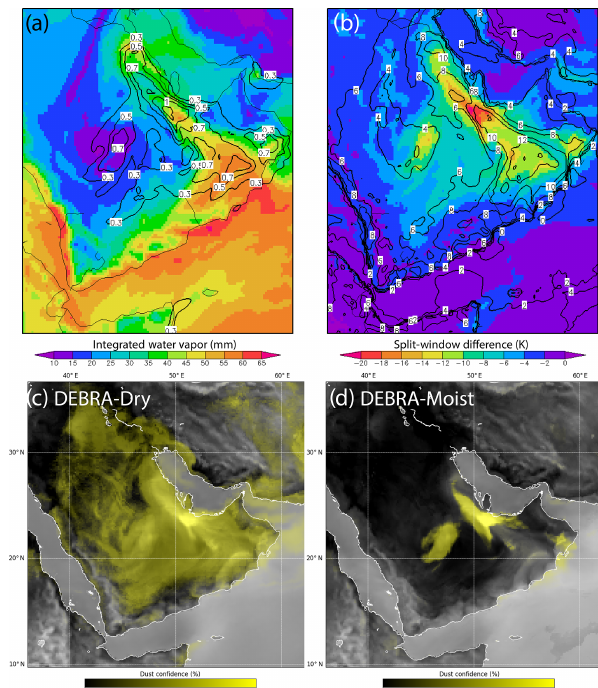
Figure 13. Model-based analysis of water vapor impacts on SWBTD-based dust detection, based on a WRF–Chem simulation valid at 12:00UTC on 4 August 2016. Panels show (a) shaded IWV overlaid by contours of aerosol optical depth at 10.35µm, (b) shaded SWBTD for a dry atmosphere overlaid by contours of differences between the SWBTD computed for the full IWV field and for a dry atmosphere, (c) synthetic DEBRA imagery for a dry atmosphere, and (d) corresponding synthetic DEBRA imagery for the full IWV